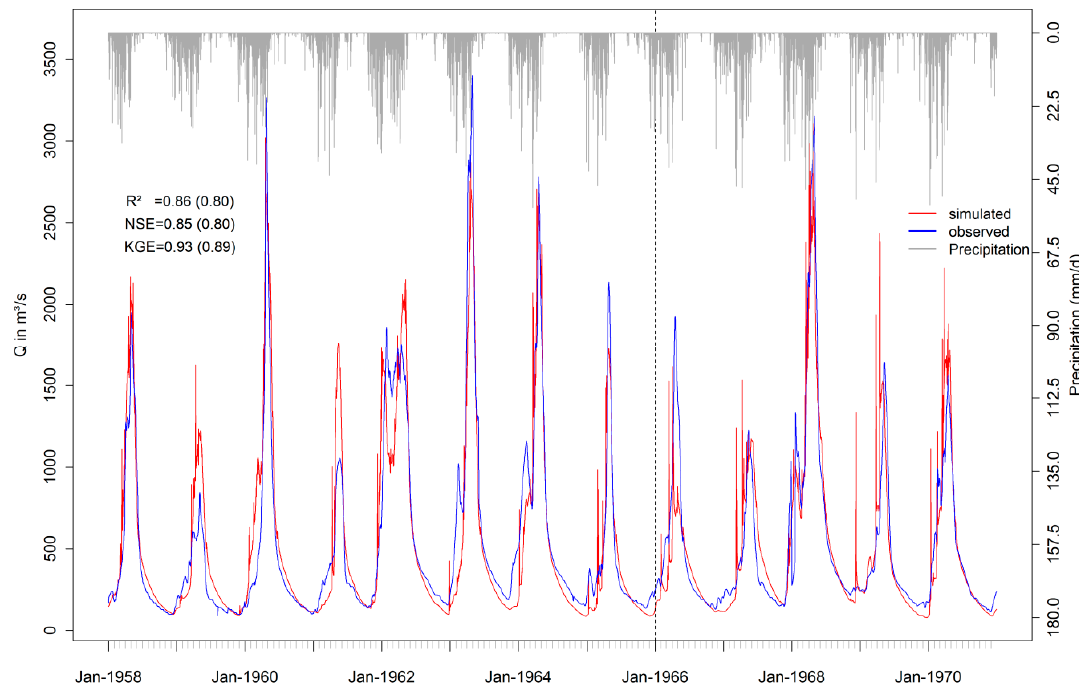
Figure 4. Hydrograph showing the observed and the simulated discharge for the calibration (1958– 1965) and the validation period (1966–1970), separated by the dashed vertical line. Statistical measures are shown within the graph and refer to the coefficient of determination (R 2 , Equation (1)), the Nash- Sutcliffe efficiency (NSE, Equation (2)) and the Kling-Gupta efficiency (KGE, Equation (3)). The values in the parentheses refer to the validation period (modified Figure after Näschen et al. [23]).